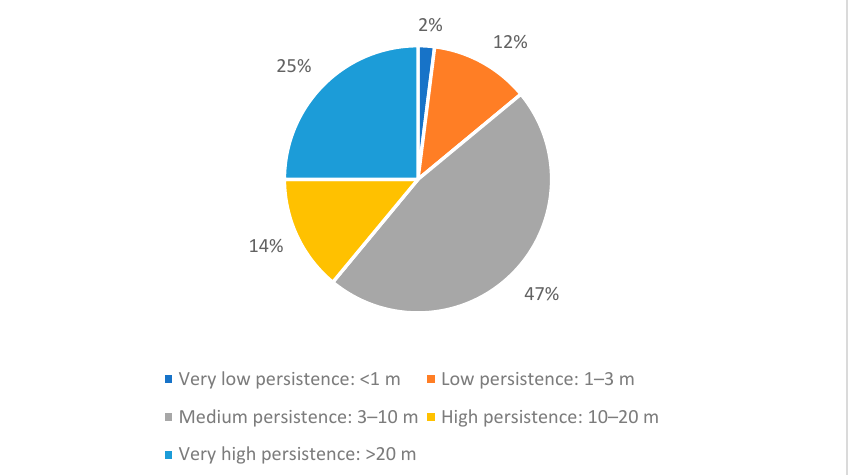
Figure 8. Percentage of main joint systems recognized in GIS with the classification of joint persis- tence [50].